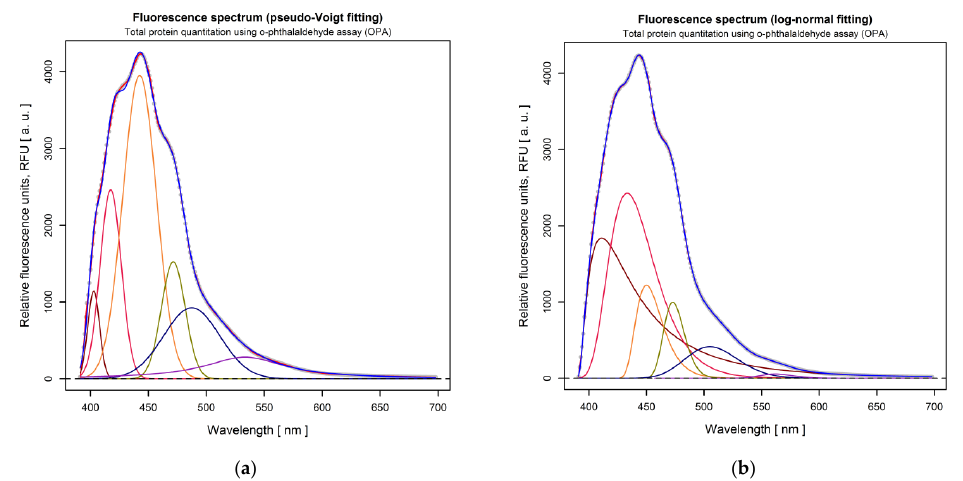
Figure 11. Total protein quantitation using OPA assay: ( a ) Fluorescence emission fitting by using Pseudo-Voigt; ( b ) log-normal distribution functions.